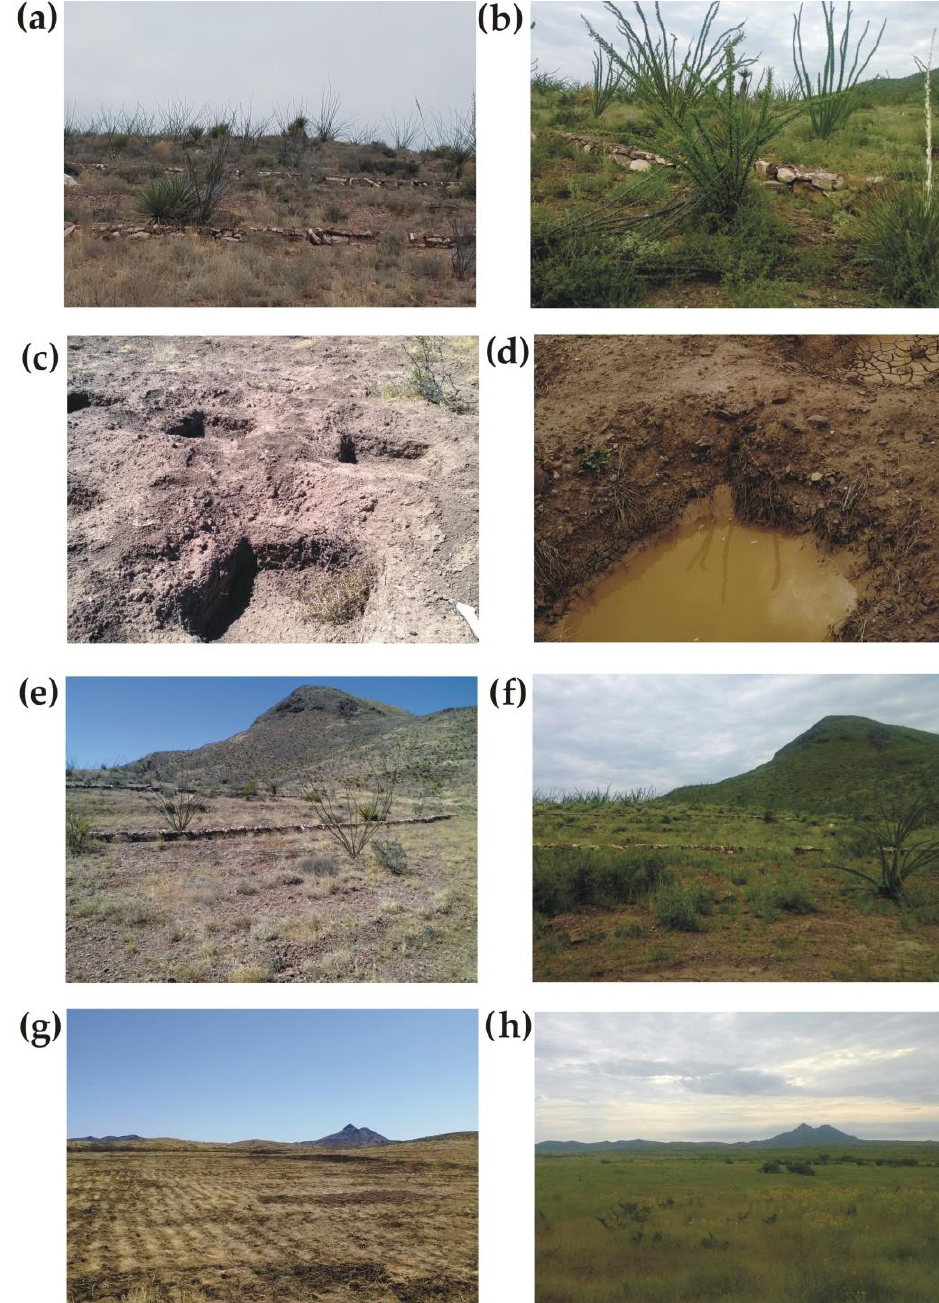
Figure A2. Water and vegetation conditions before and after precipitation for various restoration work, including rock bundles ( a , b ), water capture and infiltration pits ( c , d ), contour furrows and rock bundles ( e , f ), and land imprinting and vegetation response ( g , h ).